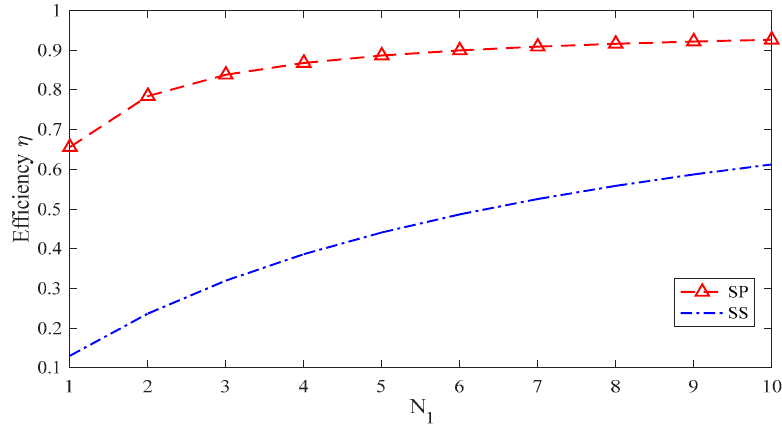
Figure 10. System efficiency varying the number of turns N 1 and the SP and SS compensation topologies.